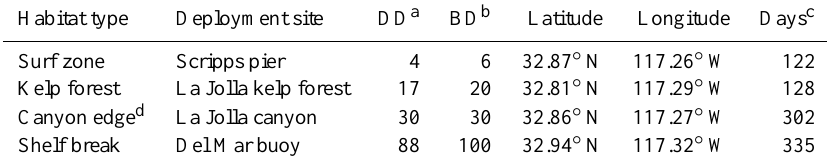
Table 1. Summary of sensor deployments Habitat